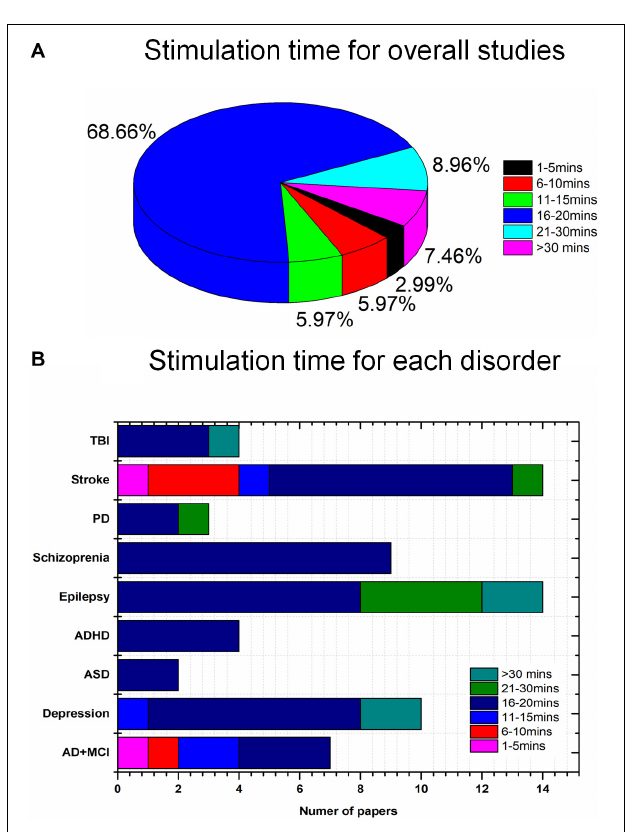
FIGURE 6 | Disease-wise stimulation time distribution (total 67 studies): (A) overall, (B) disease-wise.